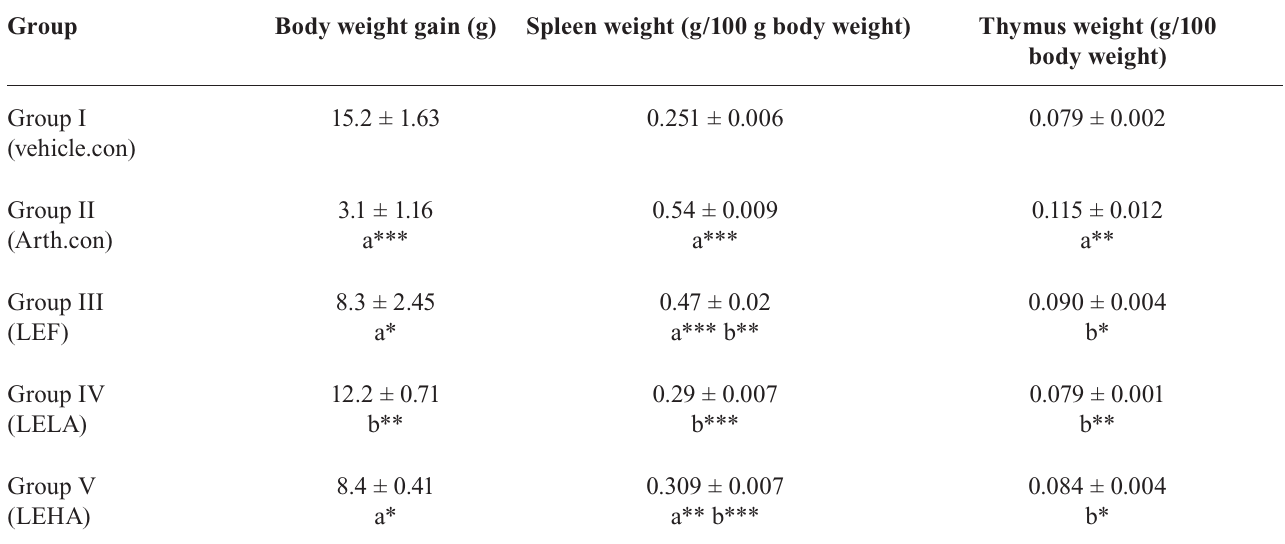
TABLE IX- C hanges in Body weight, Spleen and Thymus weight